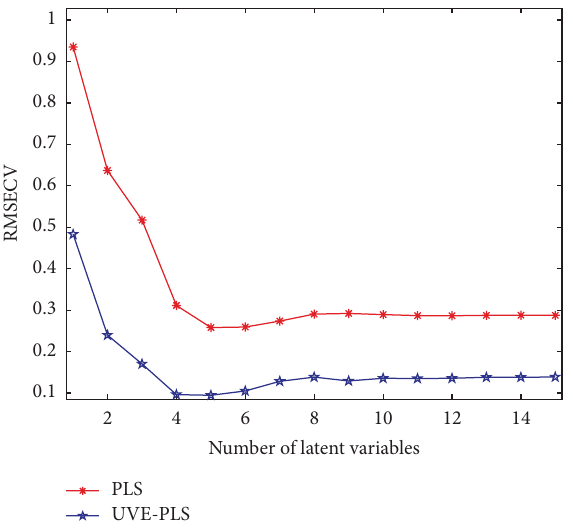
Figure 5: Scatter plots of predicted versus actual melamine concen- tration in milk samples for the PLS model.